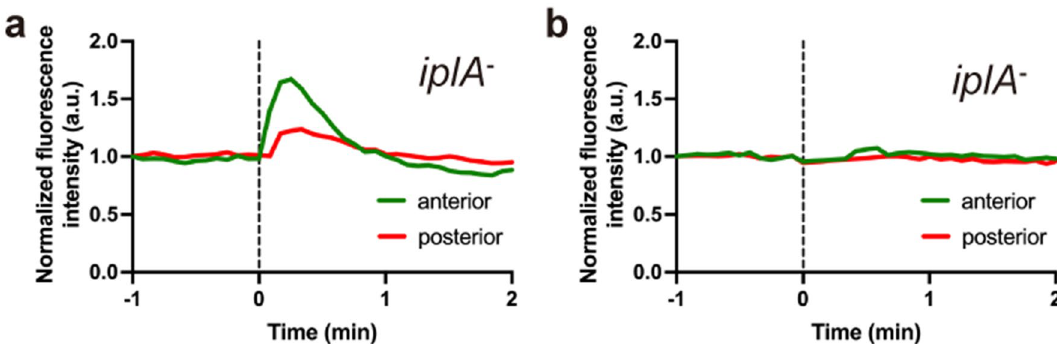
Figure 4. Intracellular Ca 2+ ([Ca 2+ ] i ) bursts in iplA − slugs induced by mechanical stimulation. [Ca 2+ ] i was monitored in iplA − slugs expressing GCaMP6s after mechanical stimulation with a plastic rod. ( a ) Representative time courses of the mean fluorescence intensity of GCaMP6s in the anterior (green) and posterior (red) regions of a slug showing [Ca 2+ ] i bursts. ( b ) Representative time courses of mean fluorescence intensity of GCaMP6s in a slug showing no [Ca 2+ ] i response. Black dashed lines indicate the time of mechanical